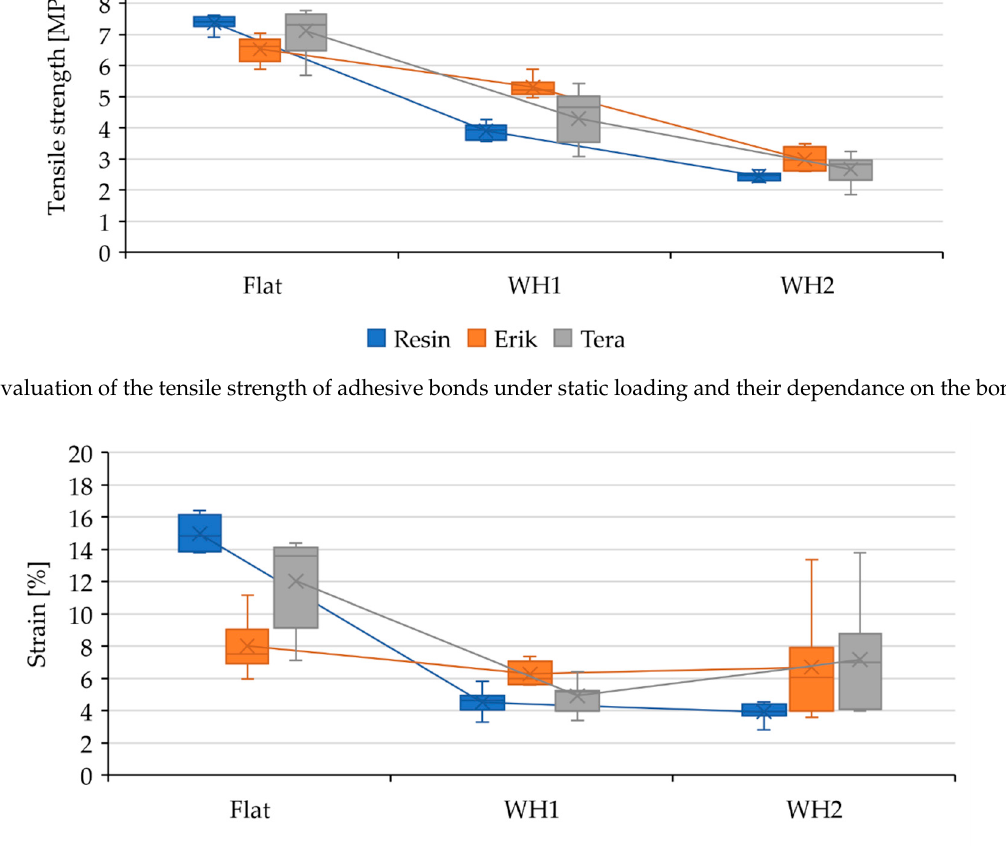
Polymers 2021 , 13 , 2872 Figure 4. Evaluation of the strain in adhesive bonds under static loading and their dependance on the bond shape.